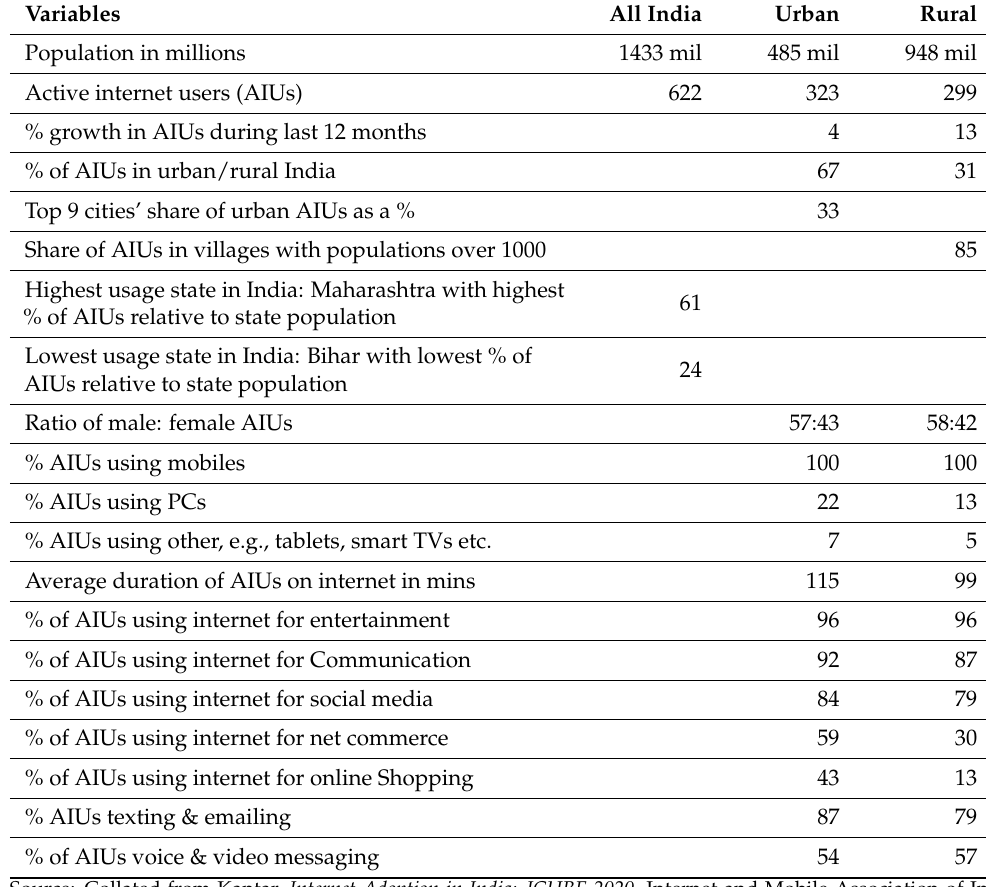
Table 1. Internet usage in urban and rural India in 2020 (based on active internet users (AIUs)).